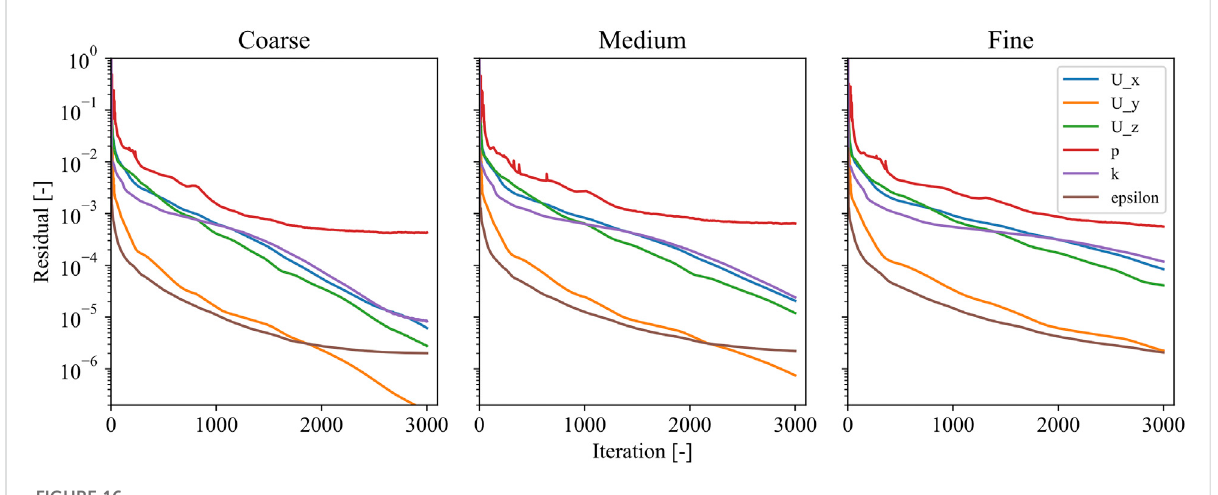
FIGURE 16 Convergence of residuals for investigated cases.